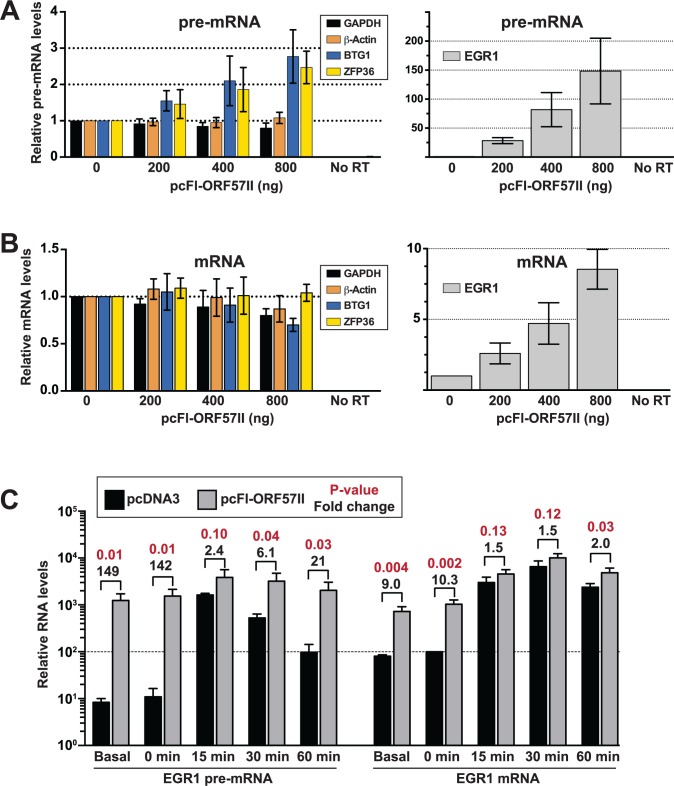
ORF57 is sufficient to up-regulate candidate pre-RNAs in HEK293 cells.(A) An ORF57 expression construct (pc-Fl-ORF57II) or vector control (pcDNA) was transfected into HEK293 cells in the indicated amounts. After 48 hrs, RNA was harvested and RT-qPCR was performed to examine the pre-mRNA levels of GAPDH, β-actin, BTG1, ZFP36 or EGR1. Because of the difference in scale, EGR1 was plotted separately (right panel). Values are shown relative to the vector alone control. (B) Same as (A) except mRNA levels were examined. (C) EGR1 pre-mRNA (left) and mRNA (right) levels were examined after serum starvation and induction as described in the text. The values are the mean of three experiments with standard deviation. The fold differences between pcFl-ORF57II and pcDNA transfected cells are listed above the brackets; p-values for these differences are shown in red (unpaired two-tailed Student’s t-test). Both pre-mRNA and mRNA values are relative to the uninduced (t = 0), vector alone EGR1 mRNA sample, which was set to 100 (dotted line). Therefore, the relative amounts of EGR1 pre-mRNA can be compared to those of EGR1 mRNA in this graph.